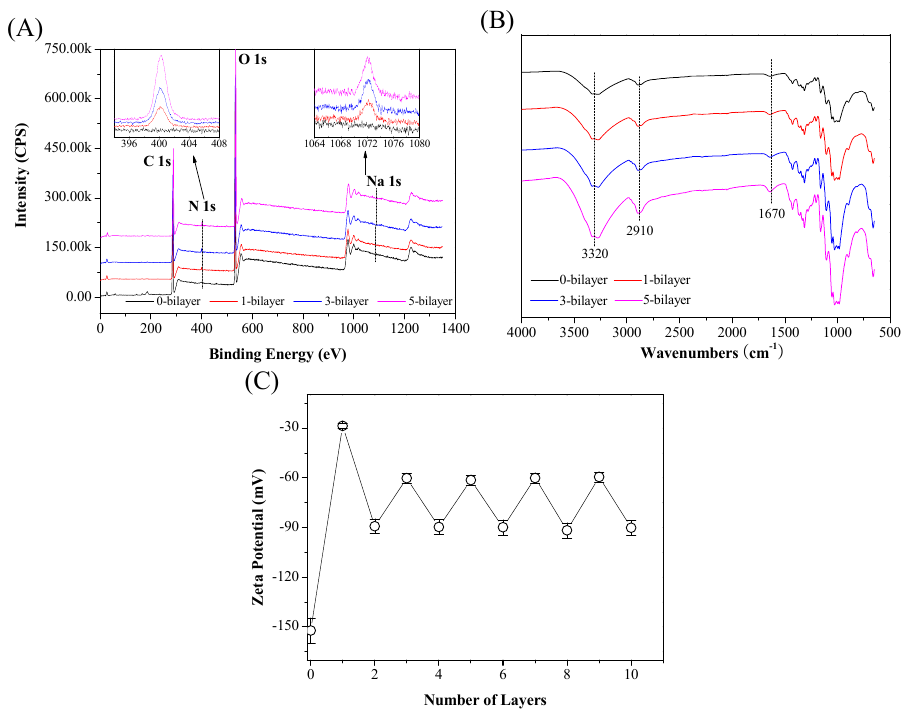
Figure 1. ( A ) X-ray photoelectron spectroscopy (XPS) spectra of original and modified paper samples, with the insets showing high-resolution XPS spectra of N 1s and Na 1s region, respectively; ( B ) FTIR spectra for different paper samples; and ( C ) the zeta potential of the original and modified cellulose fibers as a function of the number of layers.